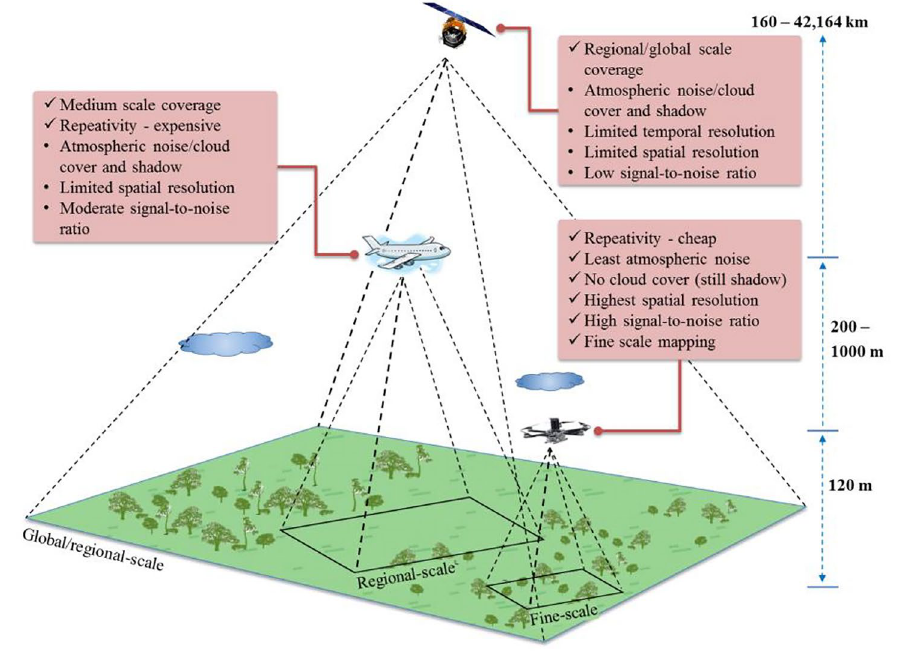
Fig. 1 A comparison of satellite, airborne and uncrewed aerial vehicle (UAV) remote sensing systems for environmental monitoring